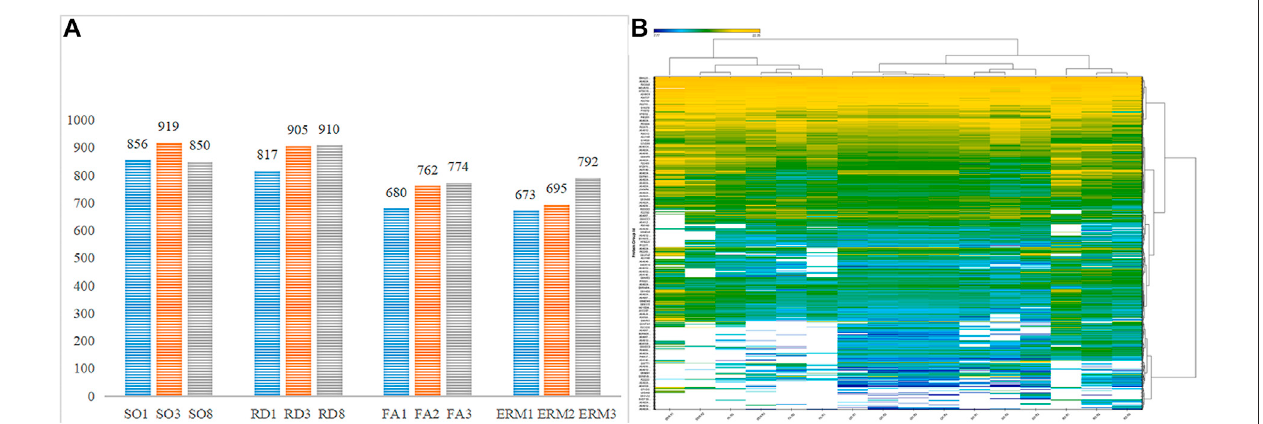
FIGURE 1 | (A) The number of protein groups in the four groups. (B) Quantitative heatmap of data-independent